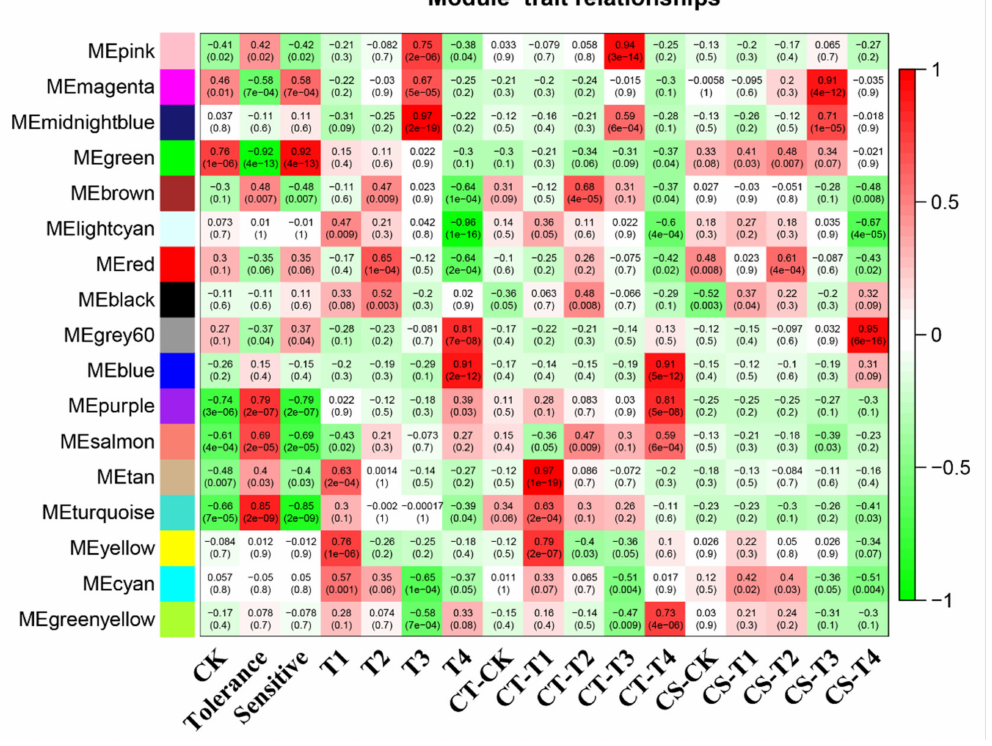
Figure 8. Module–trait relationship with samples. The number represents the correlation coefficient about modules with samples. The number in the bracket means p -value. Red color represents high correlation coefficients; green color represents low correlation